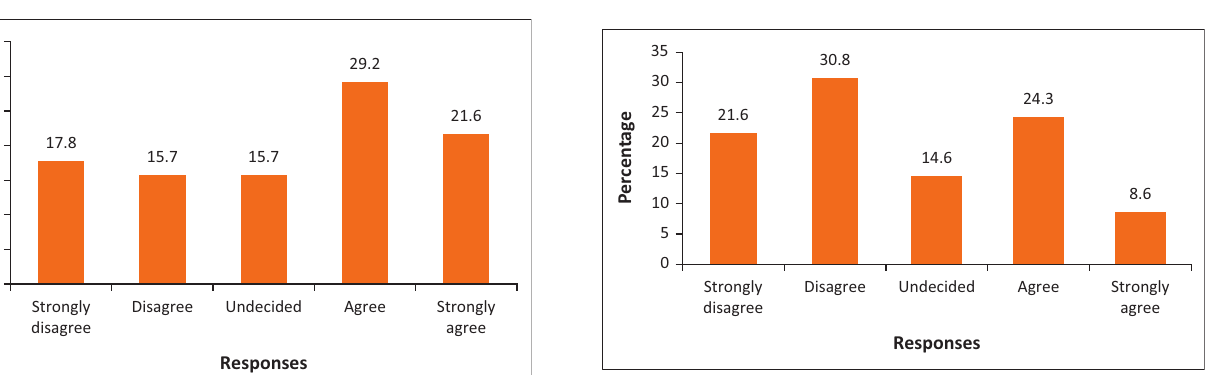
FIGURE 3: The rate of growth is reducing the number of green spaces around the city.